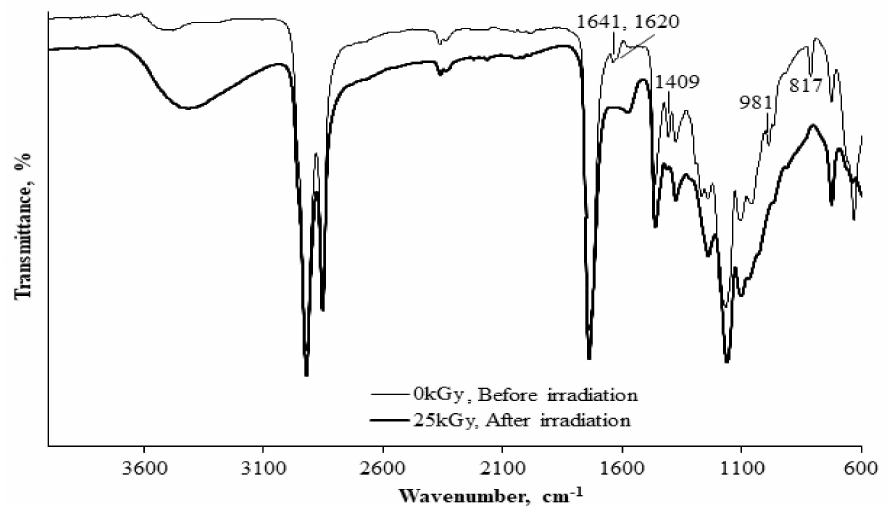
Figure 12. FTIR spectra of APO/CTAB matrix ( a ) non-irradiated; ( b ) irradiated at 25